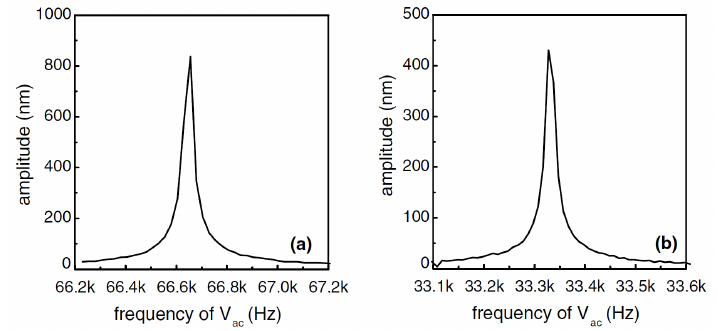
Figure 9. Measured resonant peaks for a 200- µ m SiC cantilever with ( a ) f ac = 66.65 kHz (V dc = 0.2 V) and ( b ) f ac = 33.325 kHz (V dc = 0 V) [45]. Reprinted from Microelecton. Eng., 78–79, Jiang et al., Dry release fabrication and testing of SiC electrostatic cantilever actuators, 78–79, c (cid:13) 2005, with permission from Elsevier.